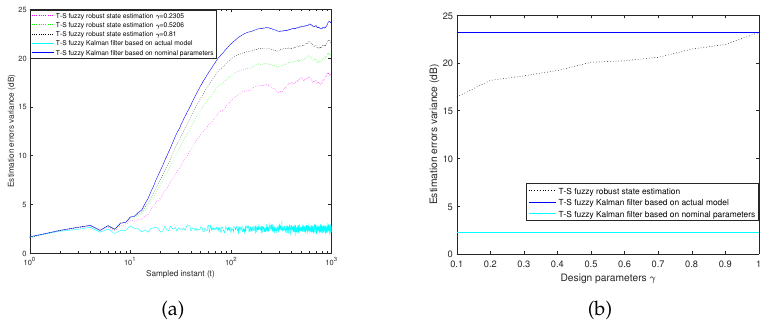
Figure 2. The model error, ε t , is fixed. ( a ) The design parameter, γ , is fixed. ( b ) The sampled instant, t , is fixed.